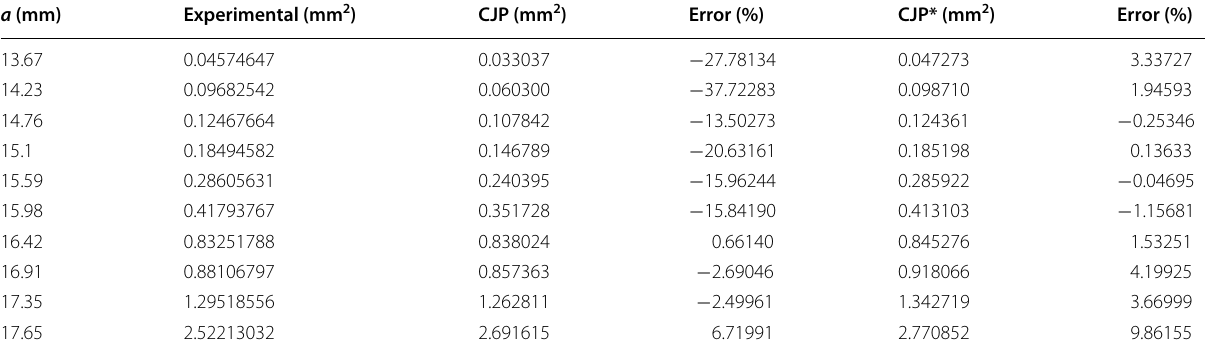
Table 3 Experimental and theoretical plastic zone area and their relative error